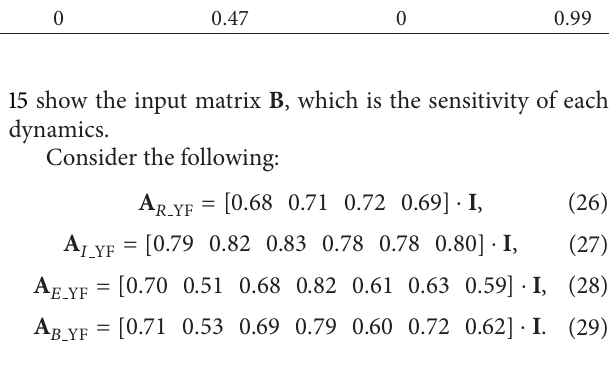
Table 5: The input matrix B 𝐸